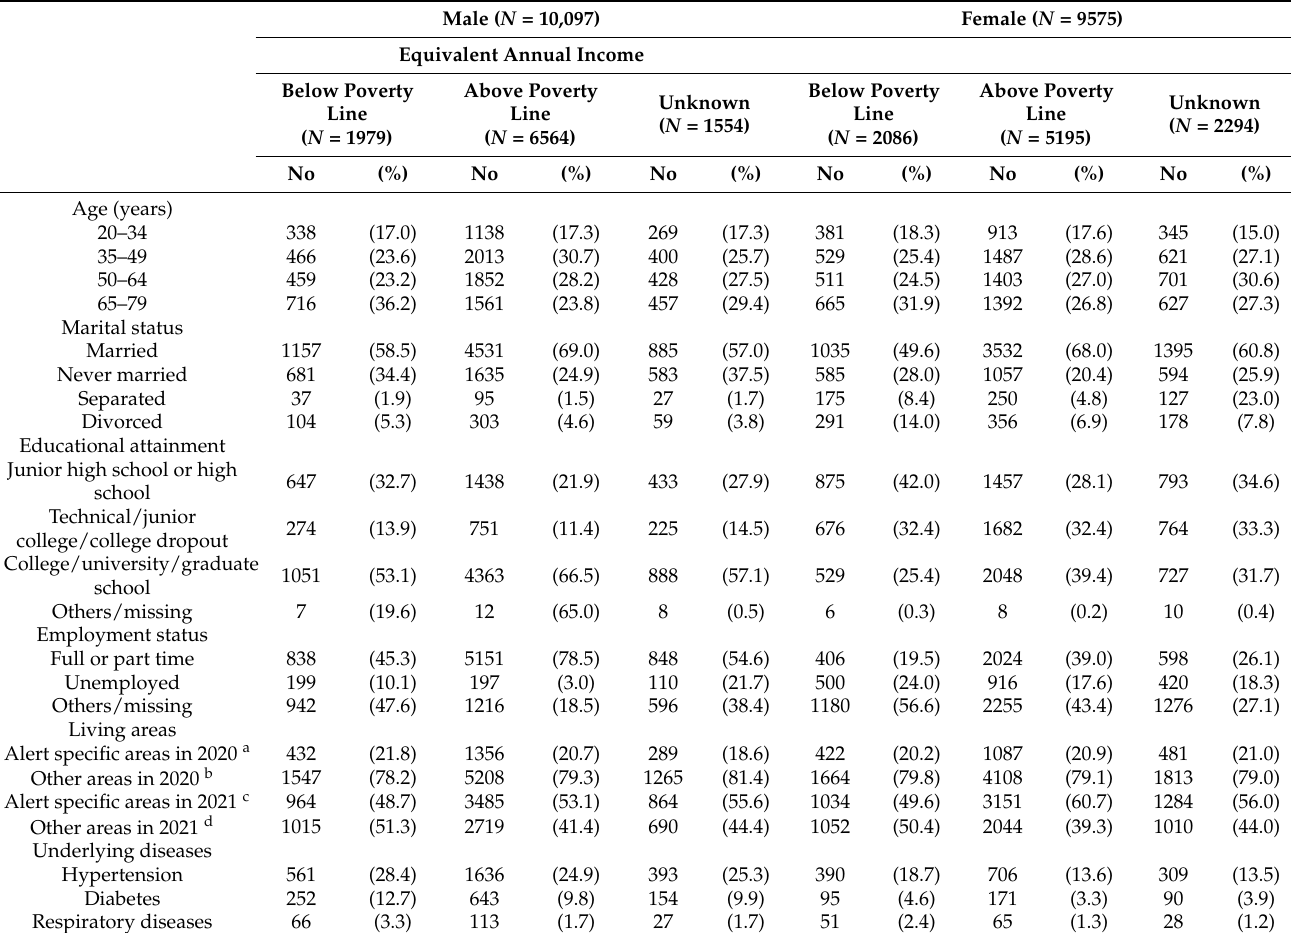
Table 1. Characteristics of participants in the